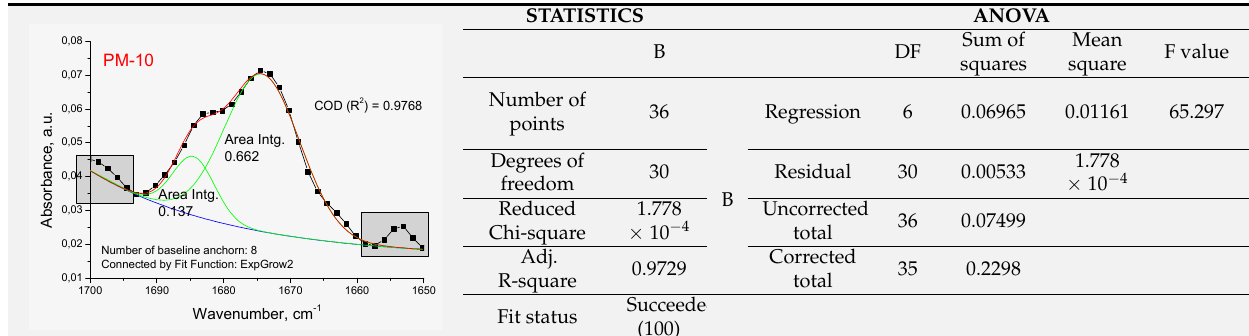
Table A2. Sample P-10.